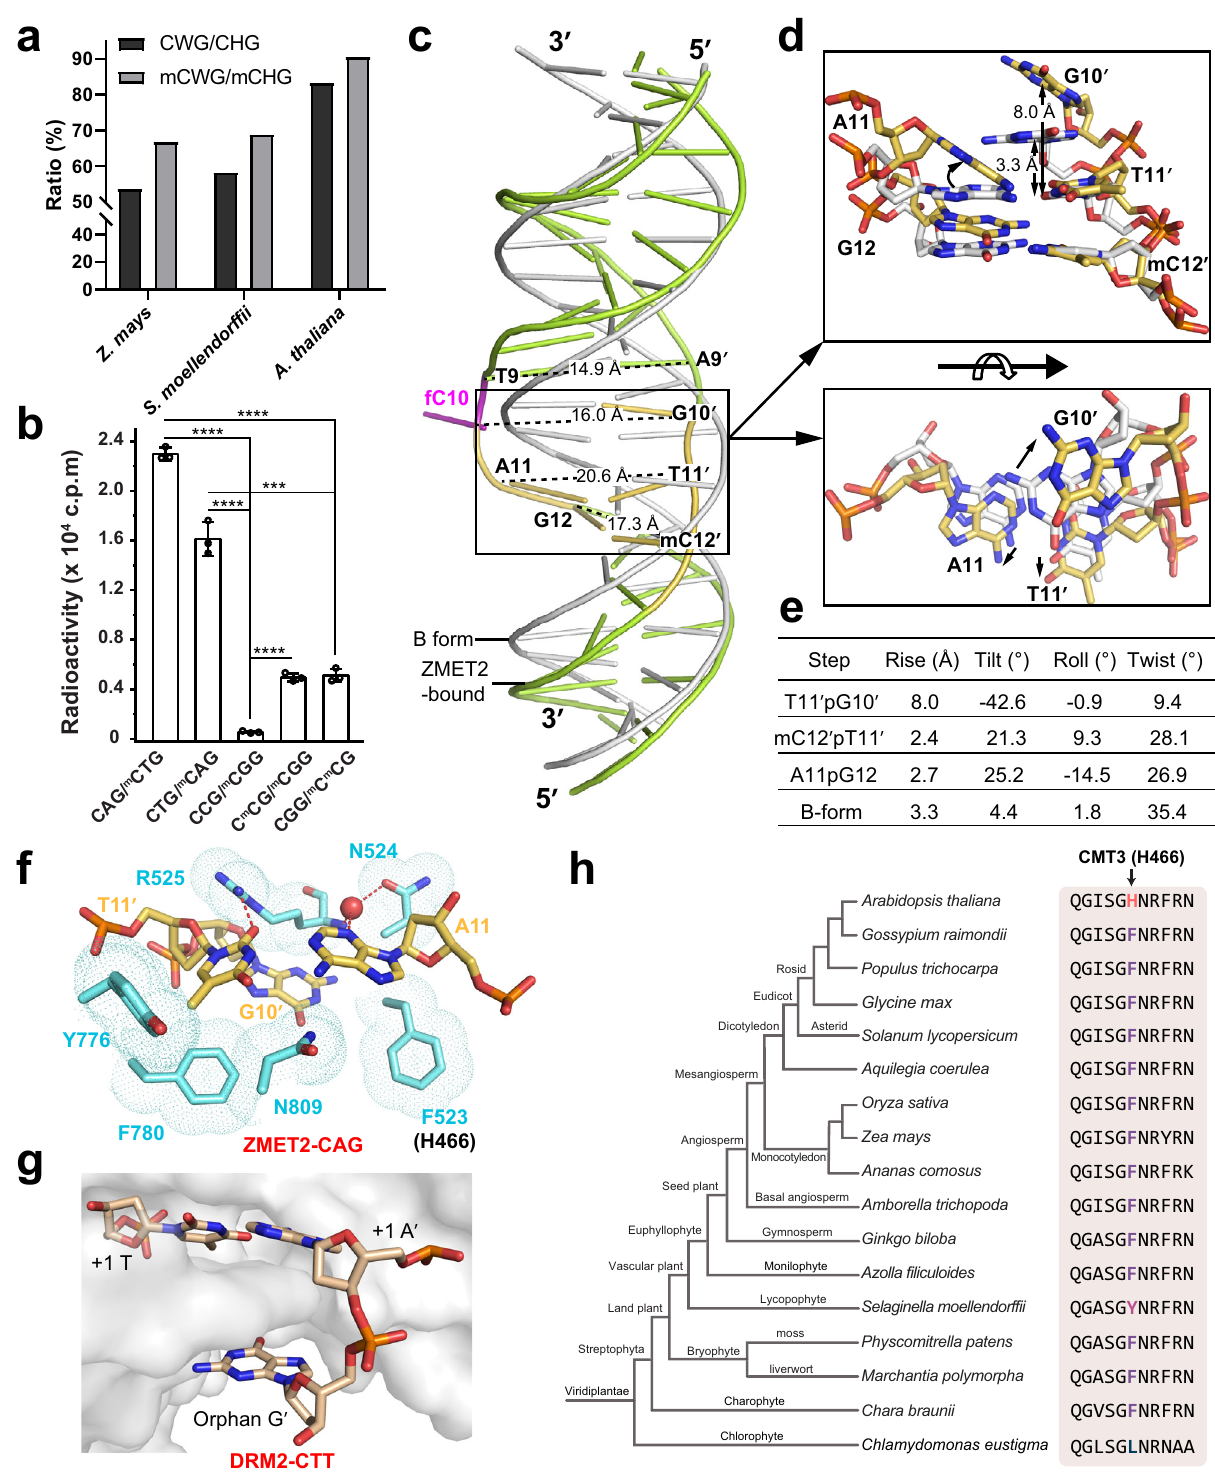
Discussion readout and DNA sequence composition coordinately control CHG methylation in plants. The crosstalk between repressive histone modi fi cations and DNA methylation is essential for maintaining heterochromatin assembly and gene silencing 5 . In addition to the positive feedback loop between H3K9me2 and heterochromatic non-CG methyla- tion, acetylation of H3 K18 and K23 is reportedly required for demethylase ROS1-mediated DNA demethylation of